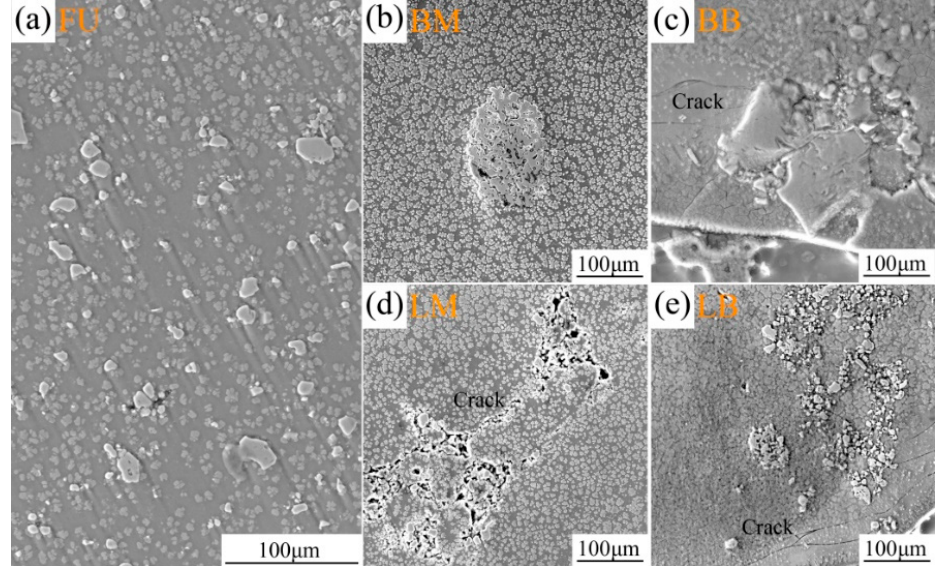
Figure 3. Morphology and distribution of 5% TiC ceramic particles in the cladding layer: ( a ) Type FU, uniform distribution in the coating; ( b ) Type BM, distribution in the middle cladding layer; ( c ) Type BB, distribution in the bottom layer; ( d ) Type LM; ( e ) Type LB.